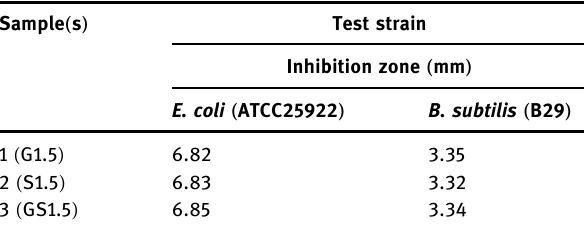
Table 4: Data of inhibition zone for three selected bionanocompo - site fi lms incorporated with CEO